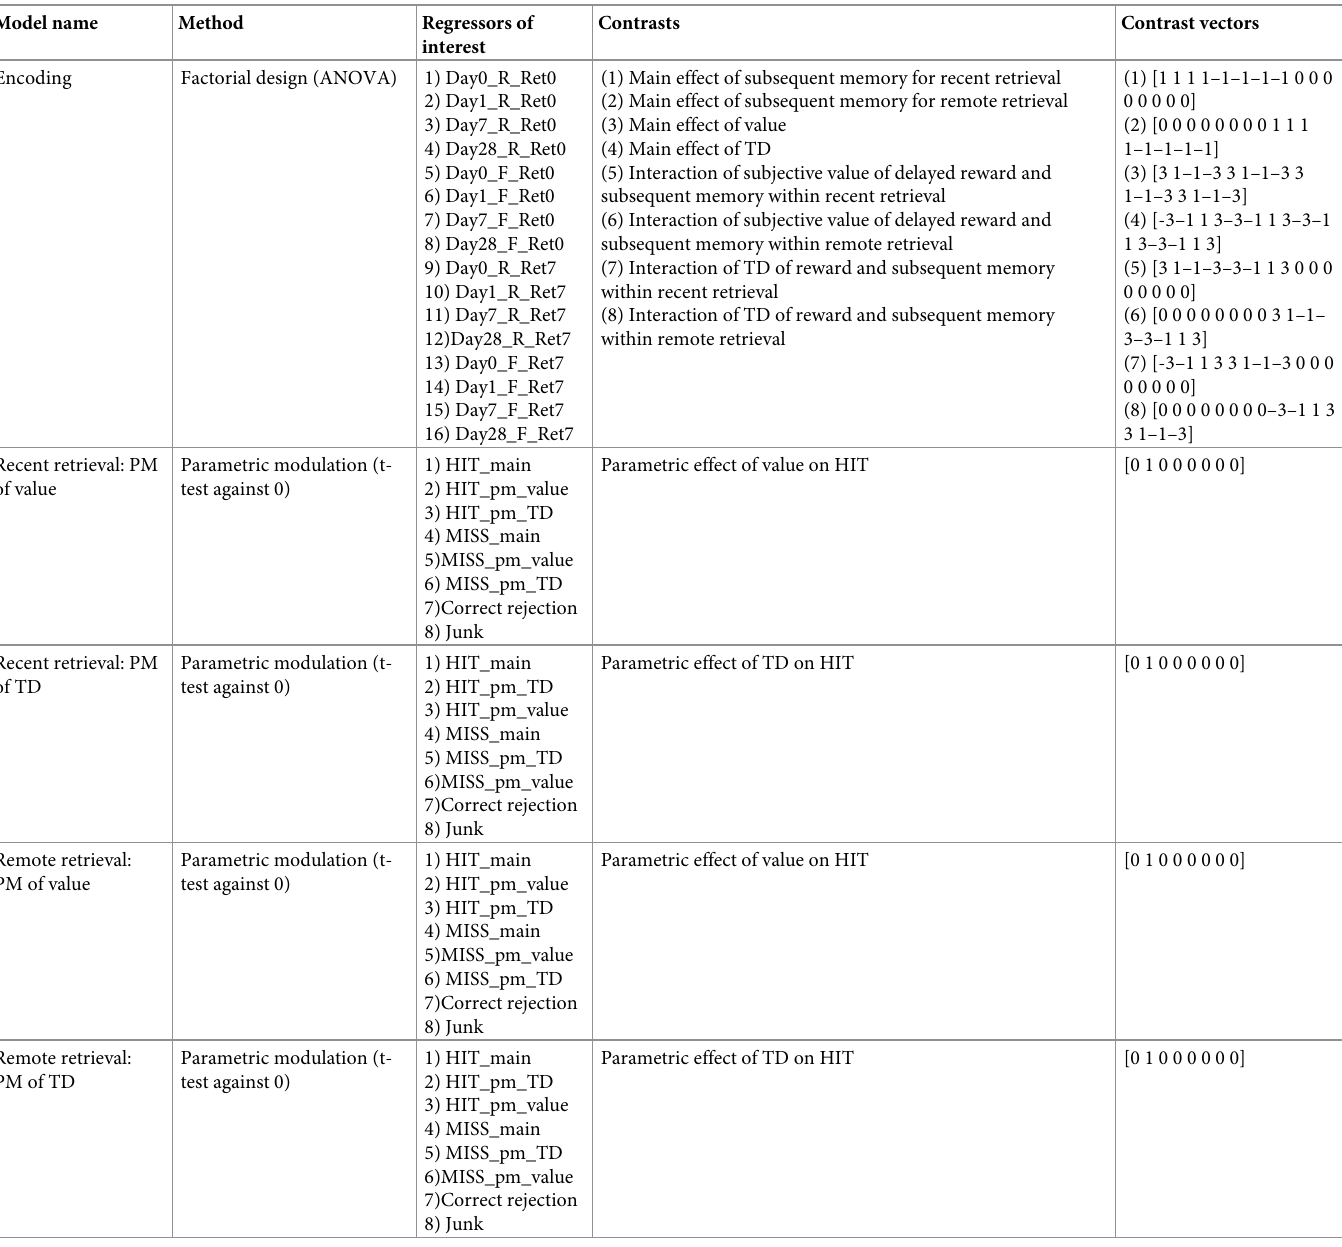
Table 1. Summary of models used for fMRI